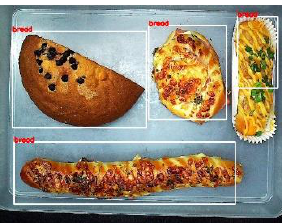
Figure 7. The false positive detection image in detection stage